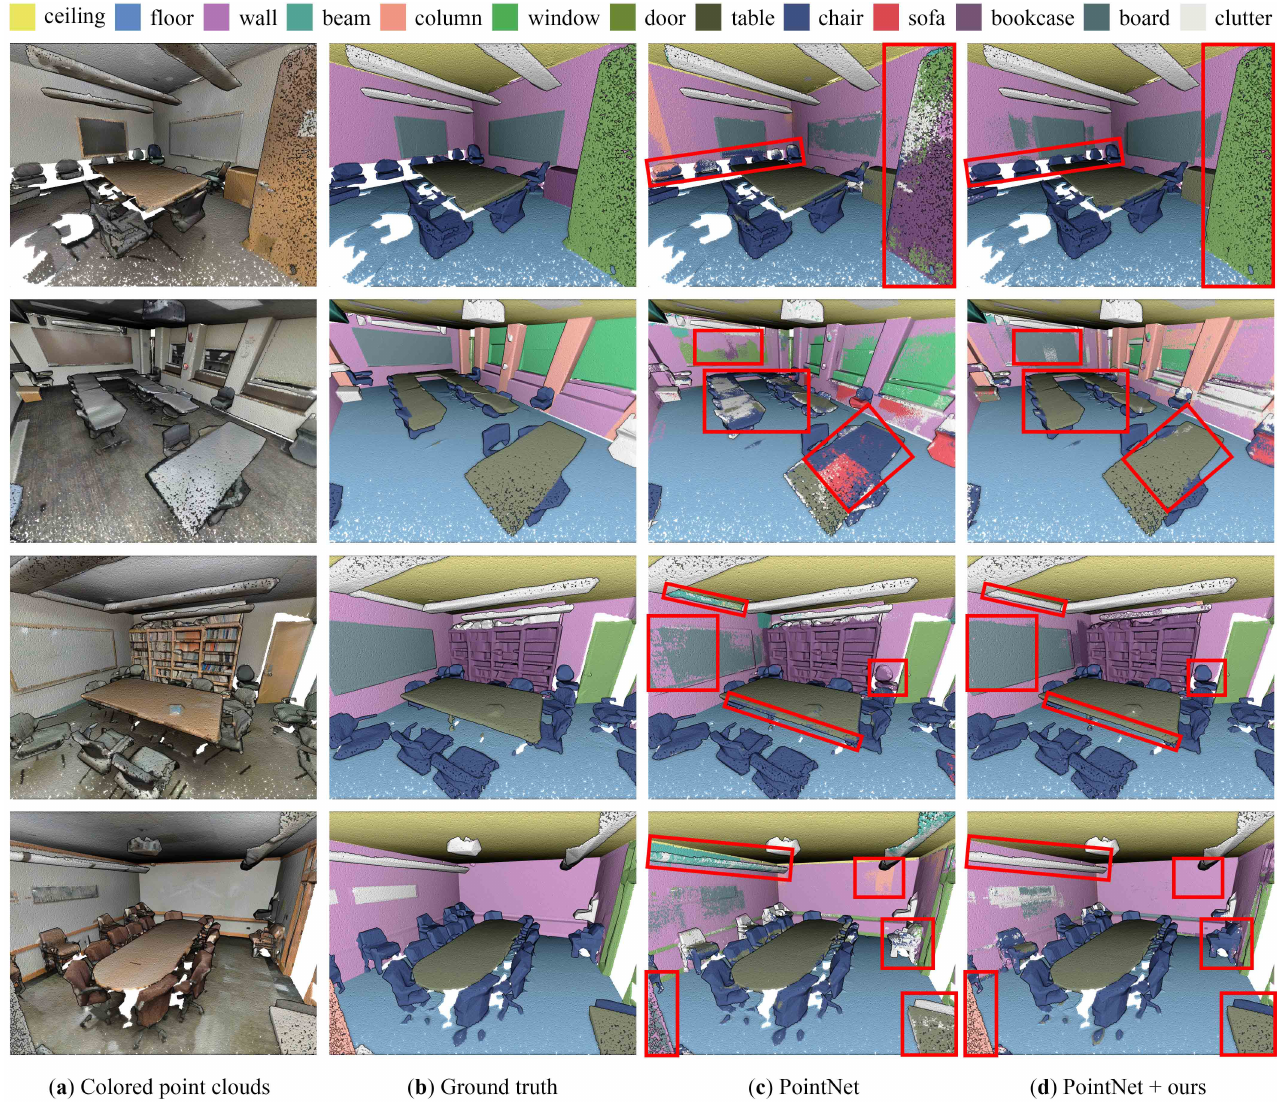
Figure 4. Qualitative comparison between the semantic segmentation results of PointNet [7] and ours on the S3DIS dataset [24]. The red rectangles highlight the major differences between the results of PointNet and